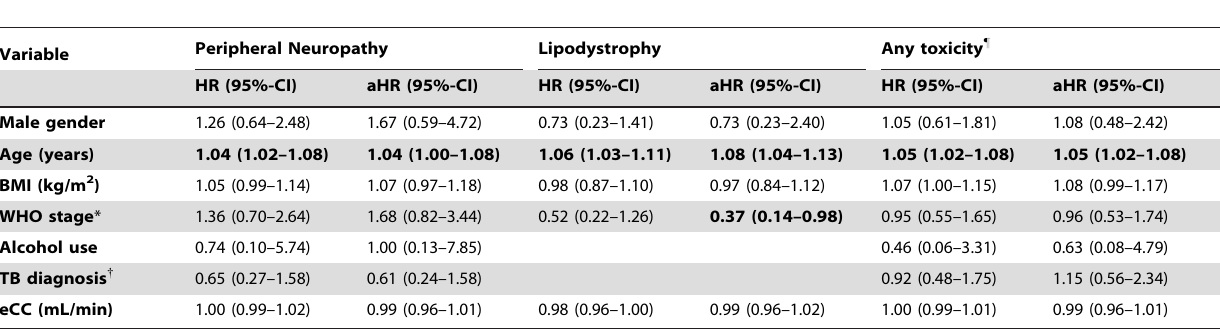
Table 4. Cox regression models of variables associated with stavudine associated side